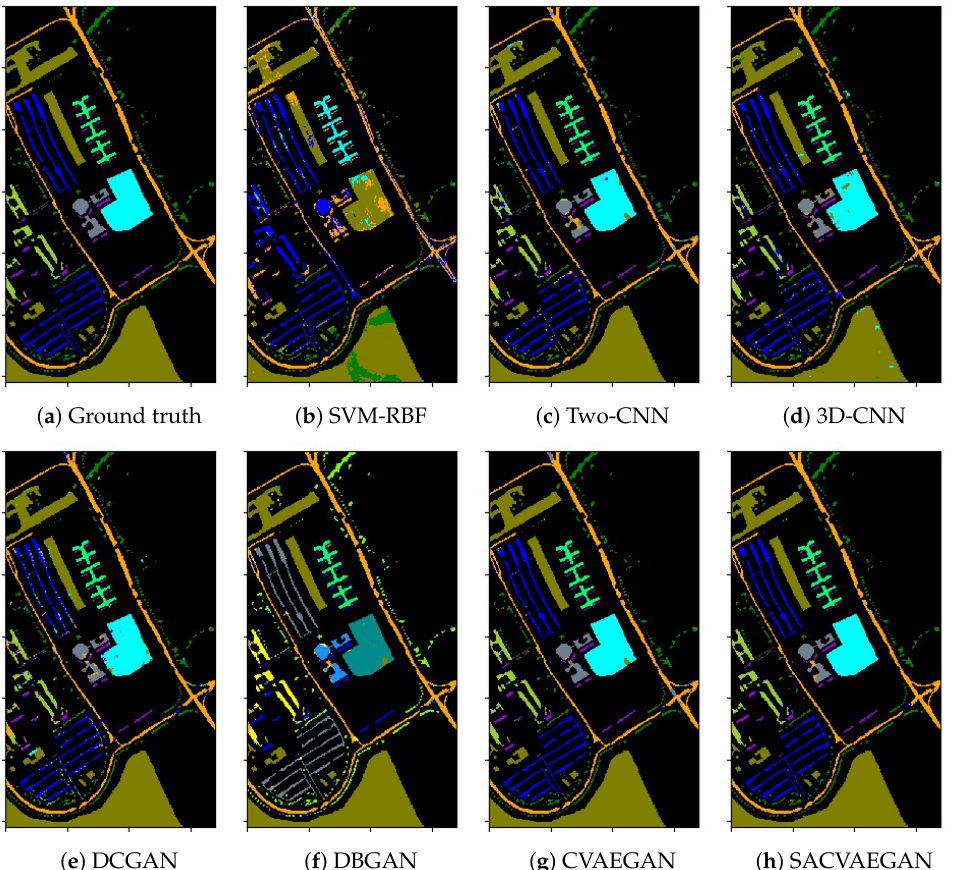
Figure 7. Illustration of the classification results on the PaviaU data set. ( a ) Ground truth, ( b ) SVM-RBF (76.00%), ( c ) Two-CNN (95.80%), ( d ) 3D-CNN (96.55%), ( e ) DCGAN (93.88%), ( f ) DBGAN (96.99%), ( g ) CVAEGAN (98.07%), and ( h ) SACVAEGAN